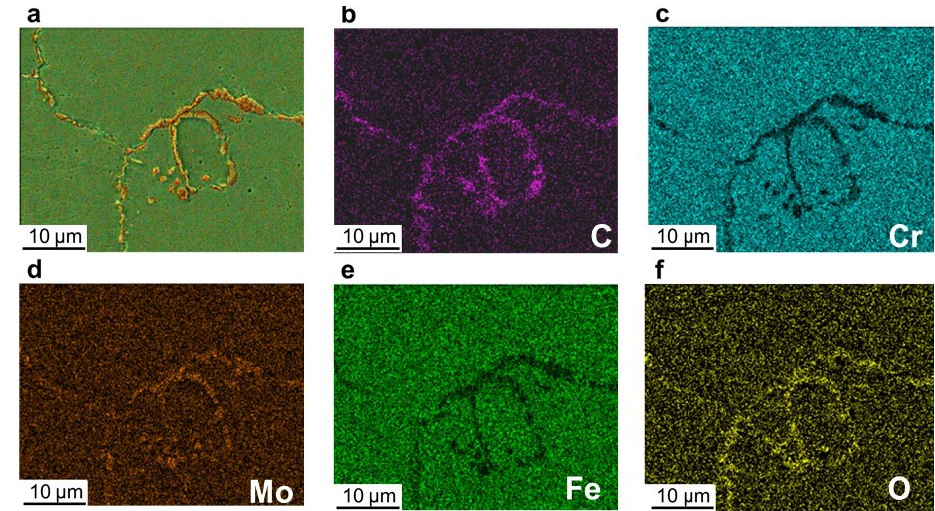
Figure 6. EDS map scanning results after furnace cooling consist of: ( a ) Complete picture; ( b ) Carbon element; ( c ) Chromium element; ( d ) Molybdenum element; ( e ) Iron element; ( f ) Oxygen element.